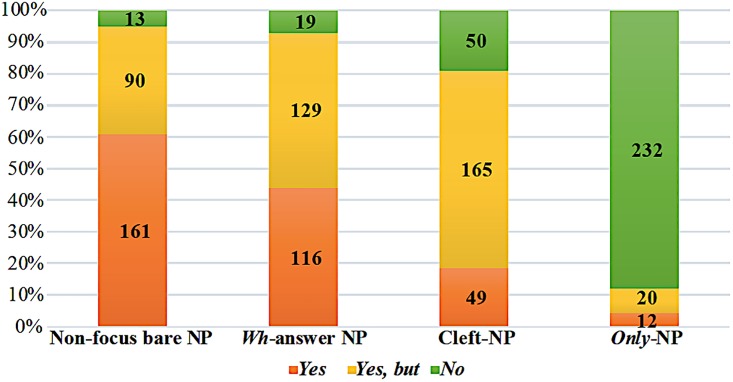
Responses to all four types of information structure.The numbers indicate the counts of each response type.